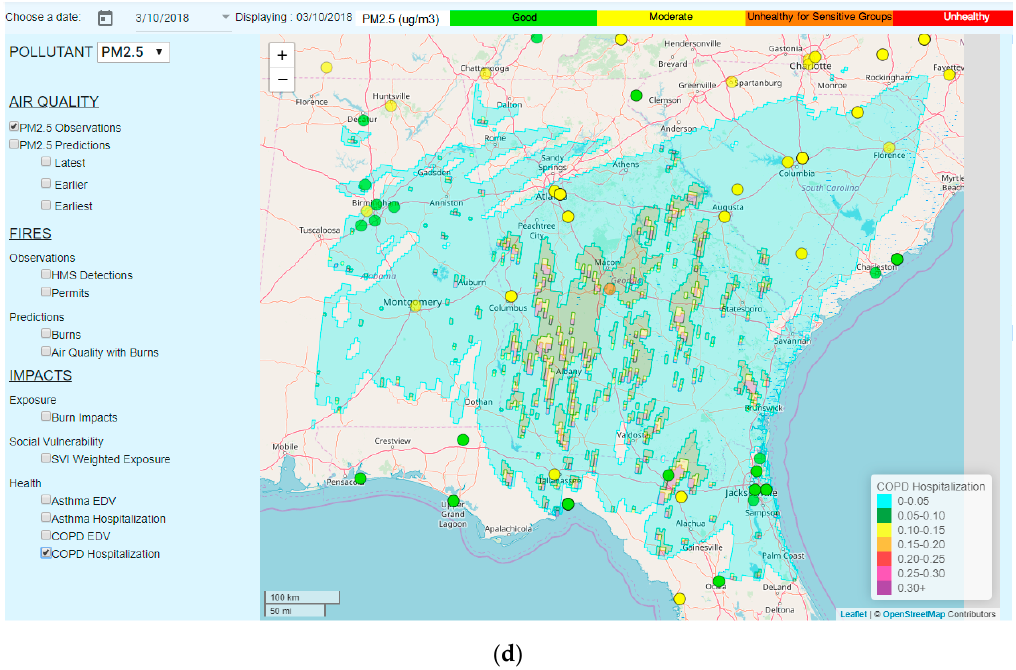
(cid:16) ∆ (cid:17) H for ( a ) the emergency department visit H 0